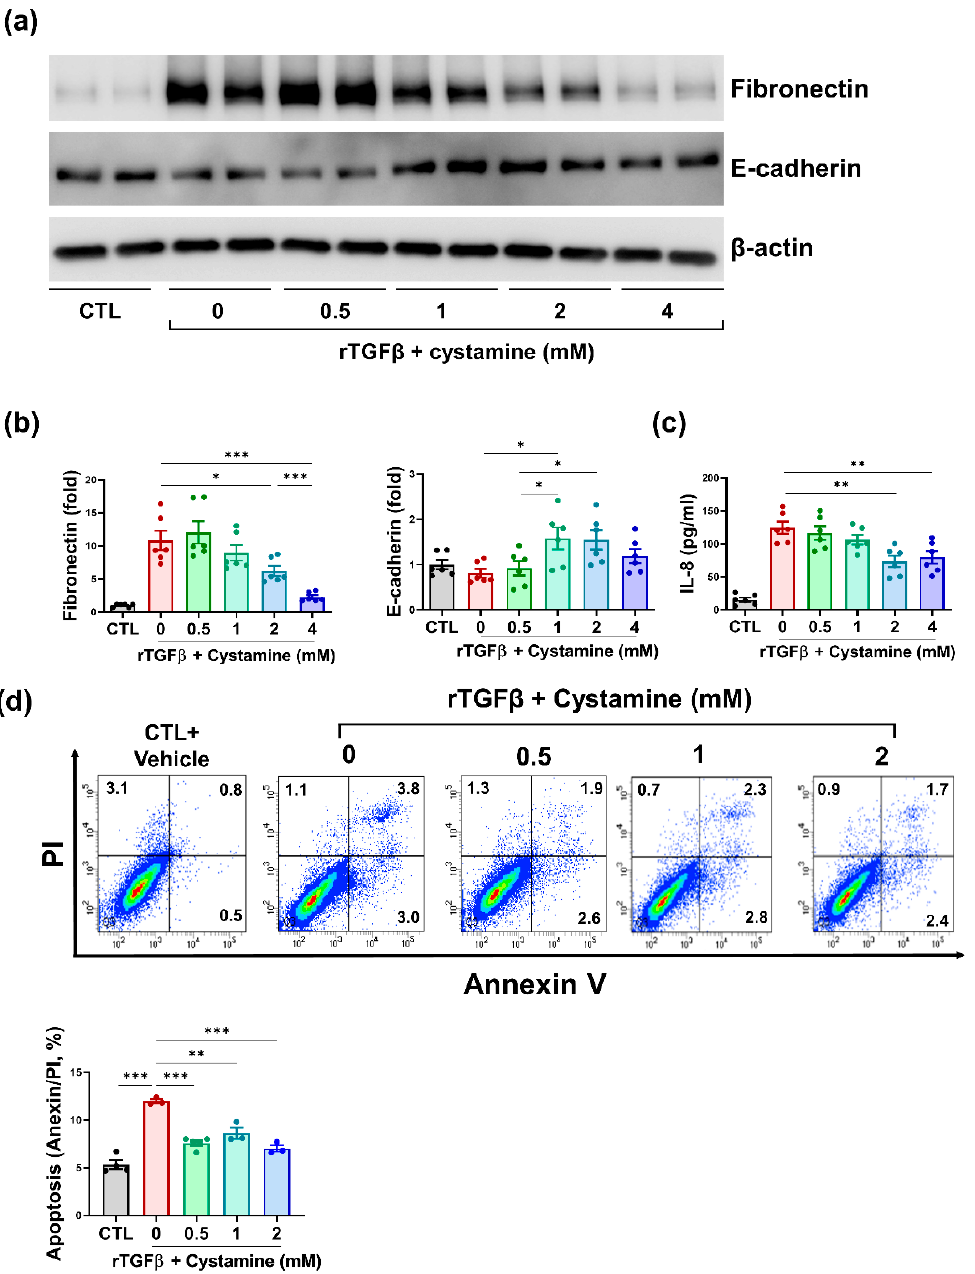
Figure 3. Cystamine-mediated inhibition of TG2 protected hTECs from rTGF β -induced injury. ( a ) Representative images of western blots for fibronectin and E-cadherin. ( b ) Semi-quantification results for fibronectin and E-cadherin. ( c ) Concentration of IL-8 in cell culture media. ( d ) Evaluation for cell death conducted using Annexin V/PI assay in hTECs 48 h after rTGF β induction (* p < 0.05, ** p < 0.01, *** p <